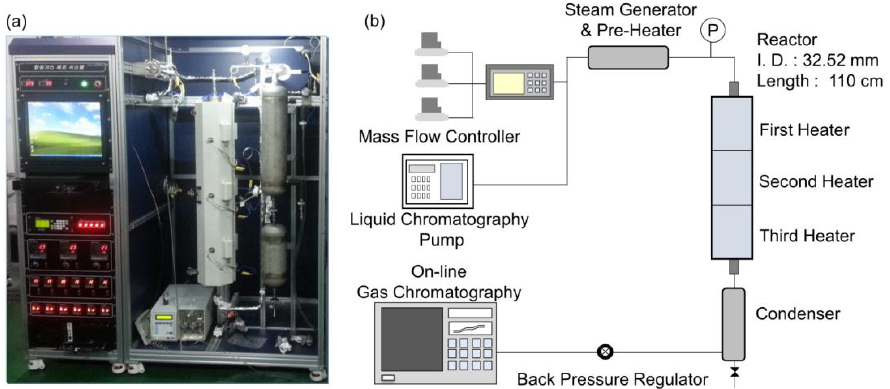
Figure 2. Bench-scale reaction system for the steam reforming of methane (hydrogen production rate of 10 L / min): ( a ) photograph of the unit and ( b ) schematic diagram of the